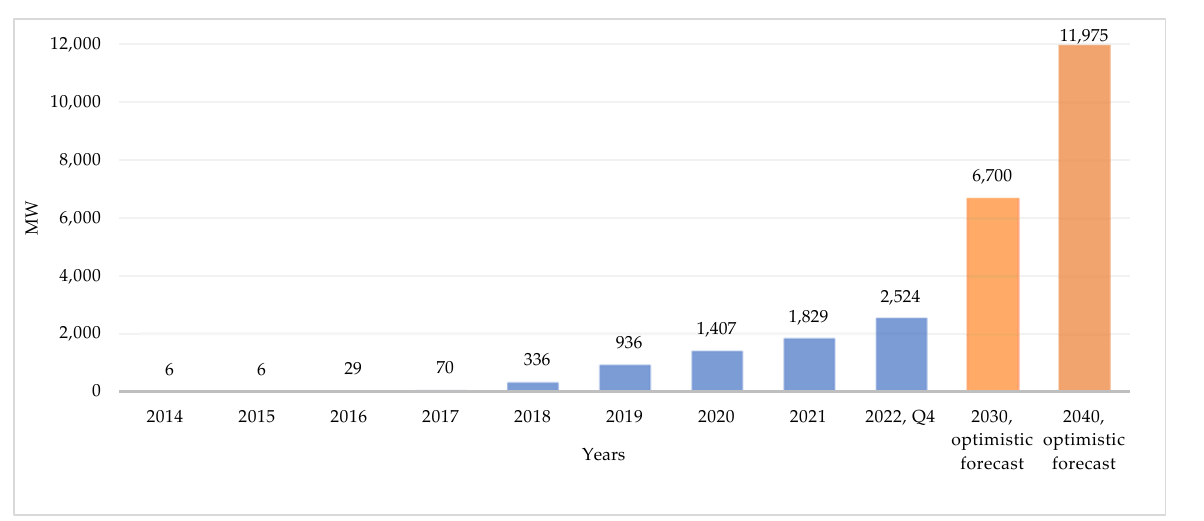
Figure 1. The development of the capacity of PV power stations in Hungary, based on [47,49] (blue colour: PV power stations already built; orange colour: the capacity of future PV power stations according to optimistic MAVIR scenarios).